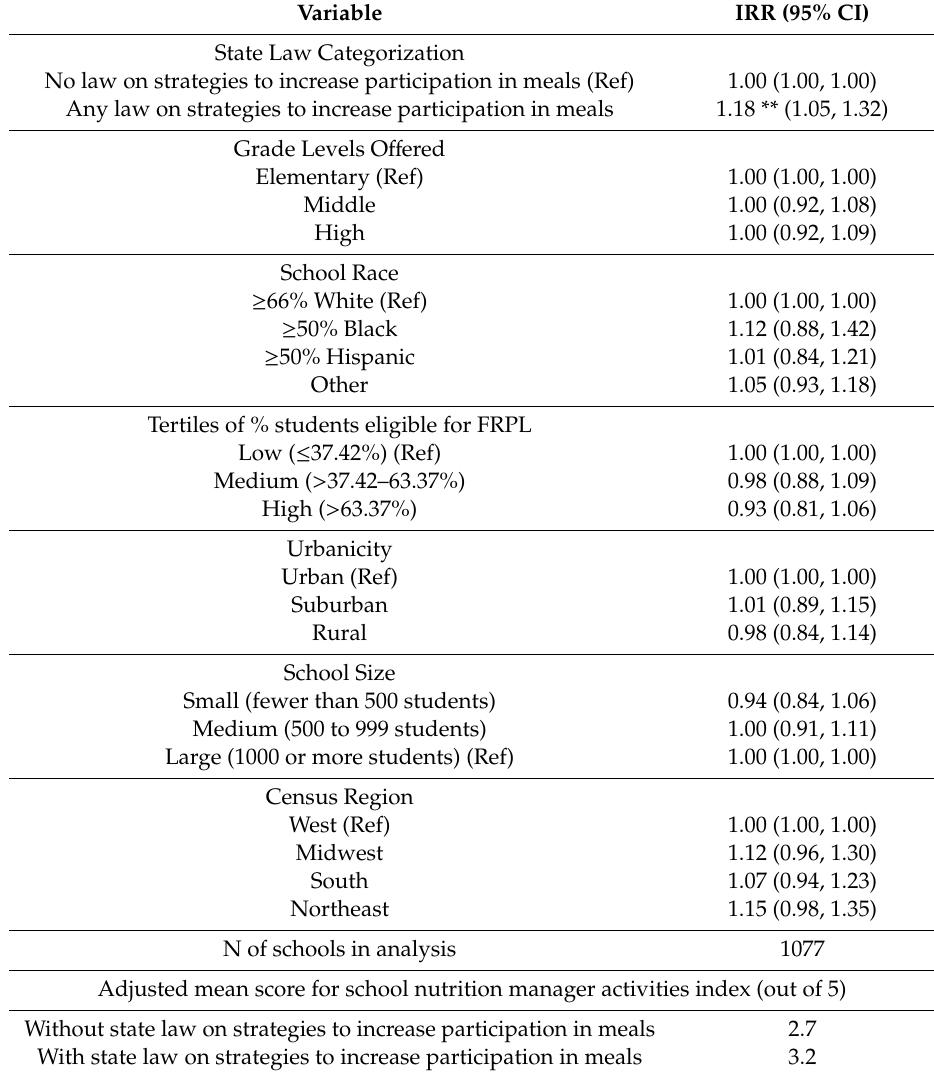
Table 5. Poisson Regression Results for the Association Between State Law on Strategies to Increase Participation in School Meals and School Nutrition Manager Activities